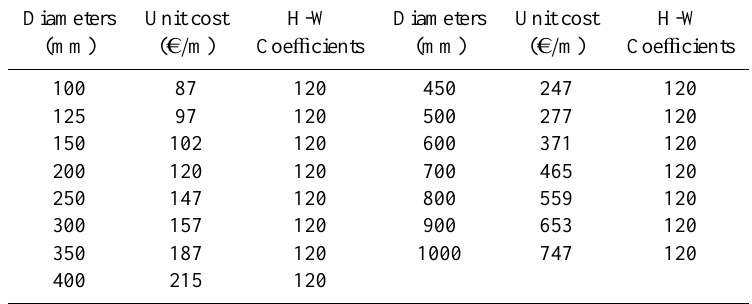
Table 3. Commercial diameters, unit costs and Hazen-Williams coe ffi cients.